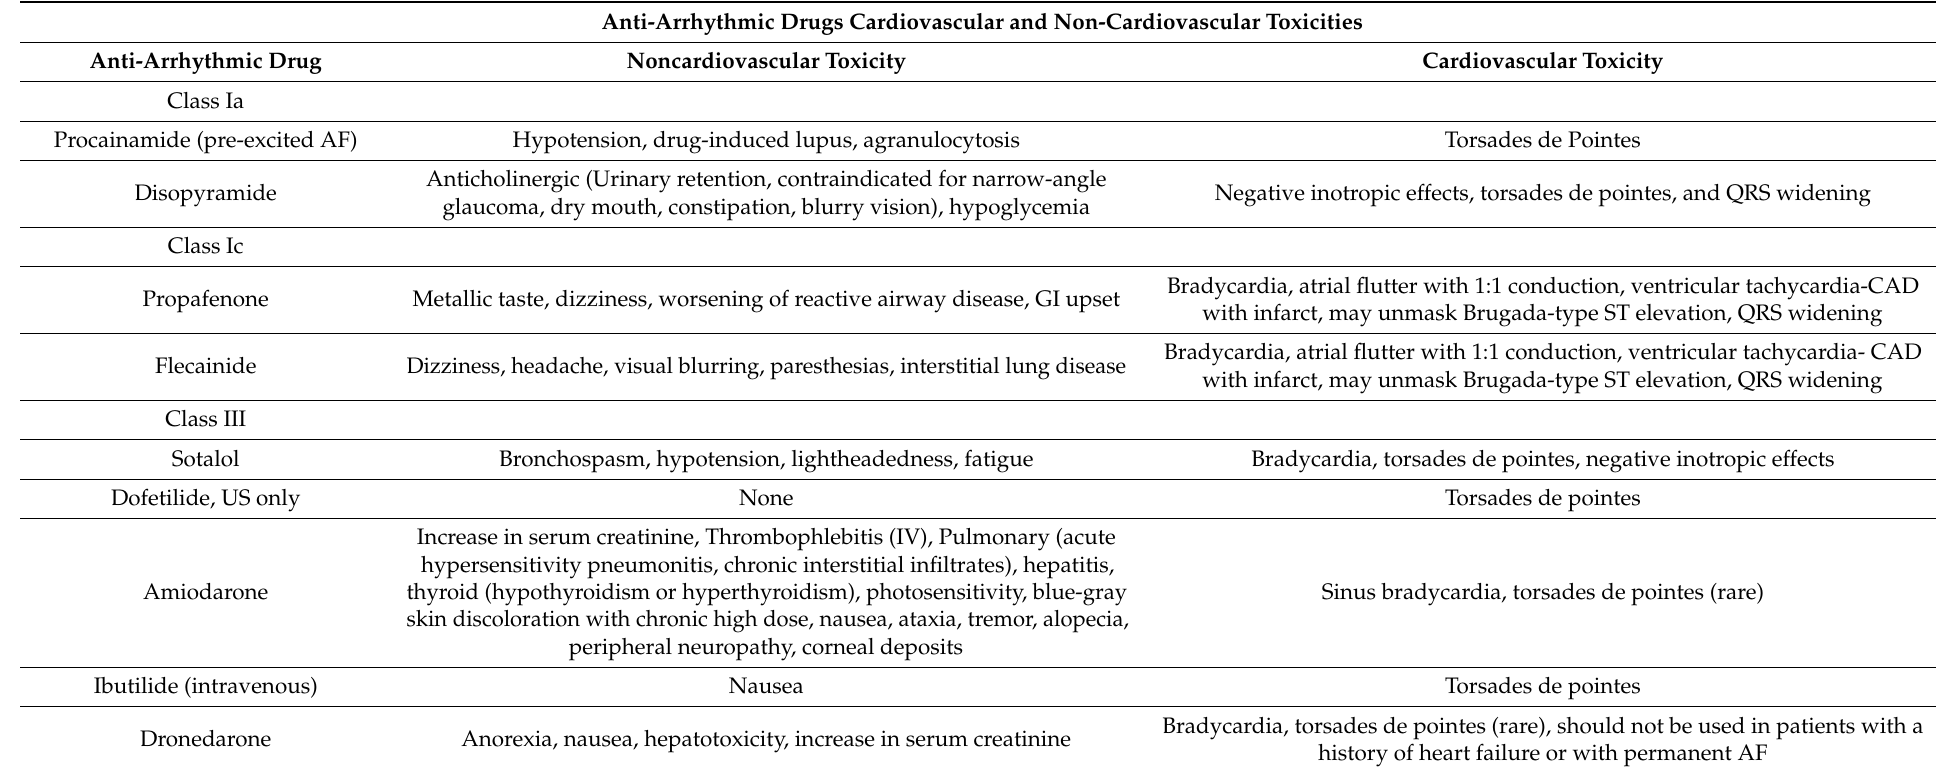
Table 2. Common toxicities associated with anti-arrhythmic drugs used for atrial